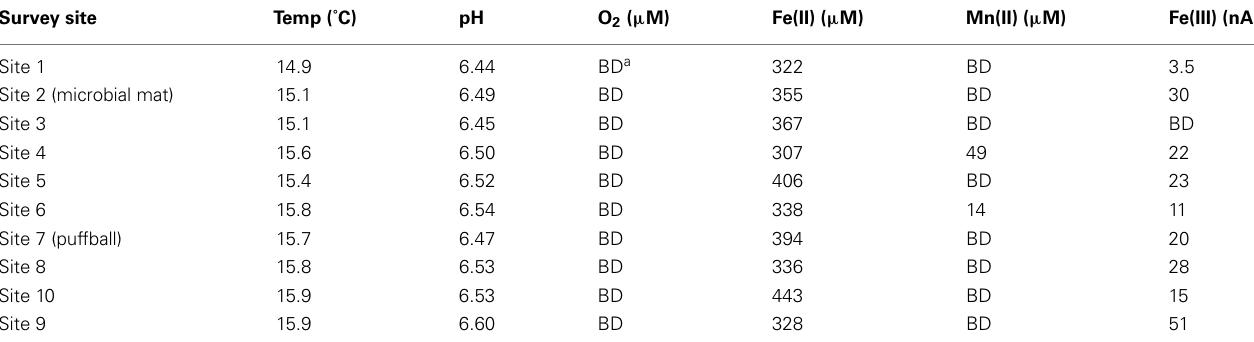
Table 1 | Results of geochemical survey.